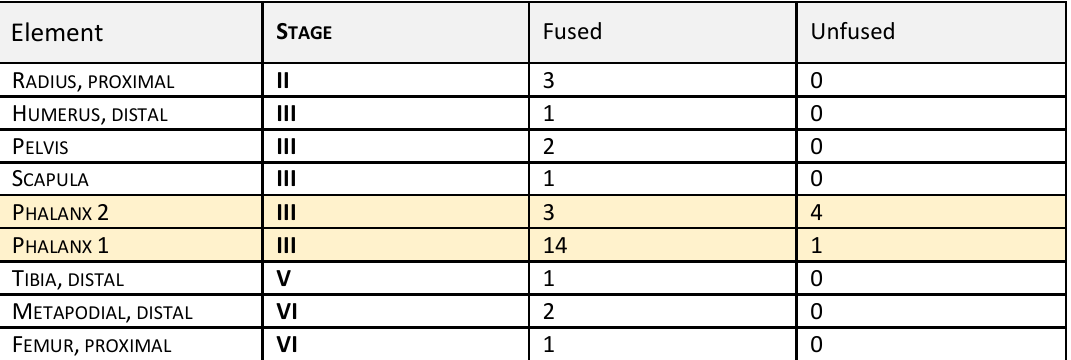
Table 5 : Epiphyseal fusion data for gazelles, grouping after Munro et al. (2009).